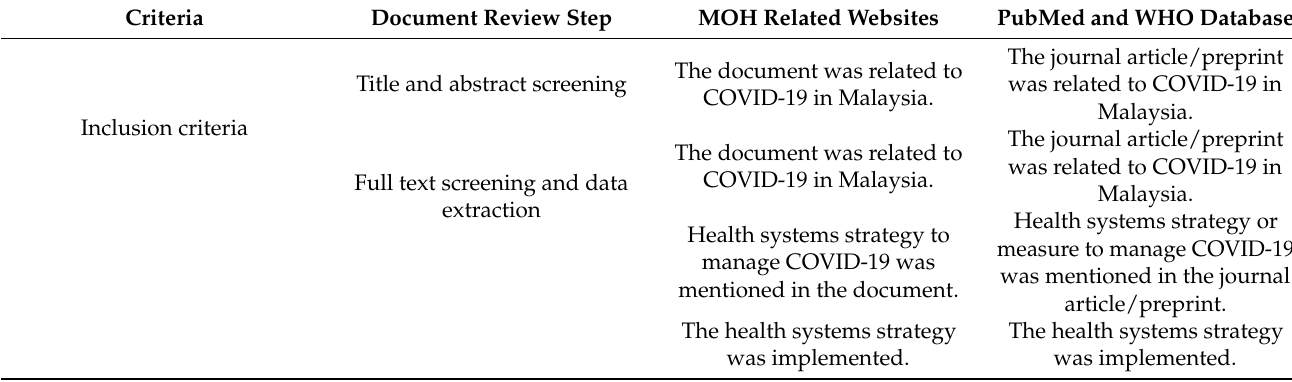
Table A2. Specific inclusion criteria applied during document review.